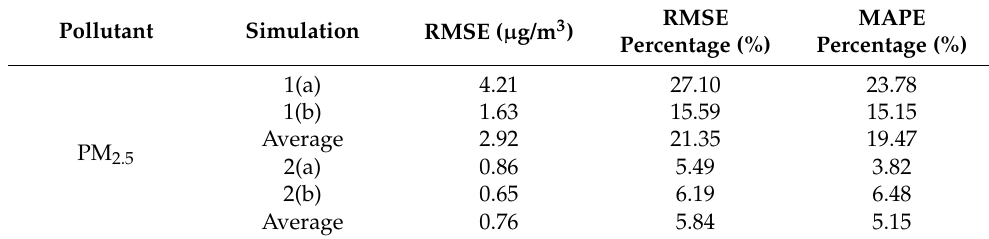
Table 7. PM 2.5 concentration test and prediction tool RMSE and MAPE results.